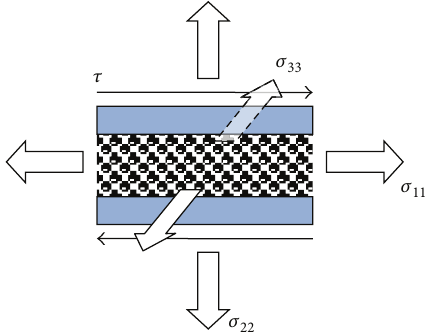
Figure 5: Normal stresses, 𝜎 𝑖𝑖 , arising during shearing. The sign of the vectors does not correspond to a specific material but is arbitrarily sketched as tension in all directions. The imposed “viscometric” shear stress, 𝜏 , is also